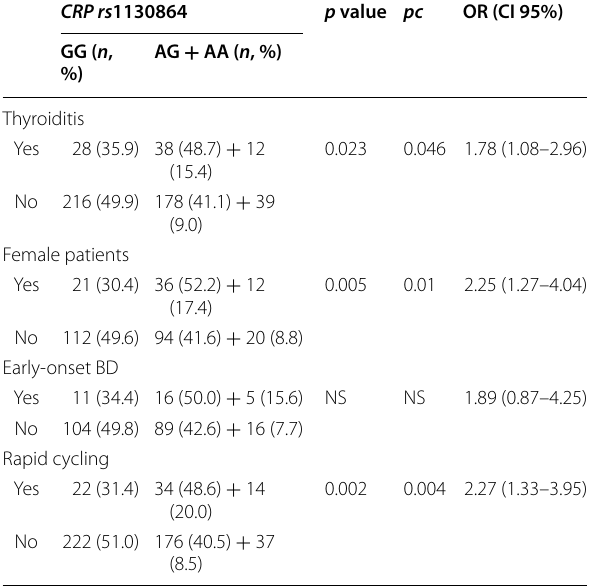
CRP C-reactive protein, OR odds ratio, CI confidence interval